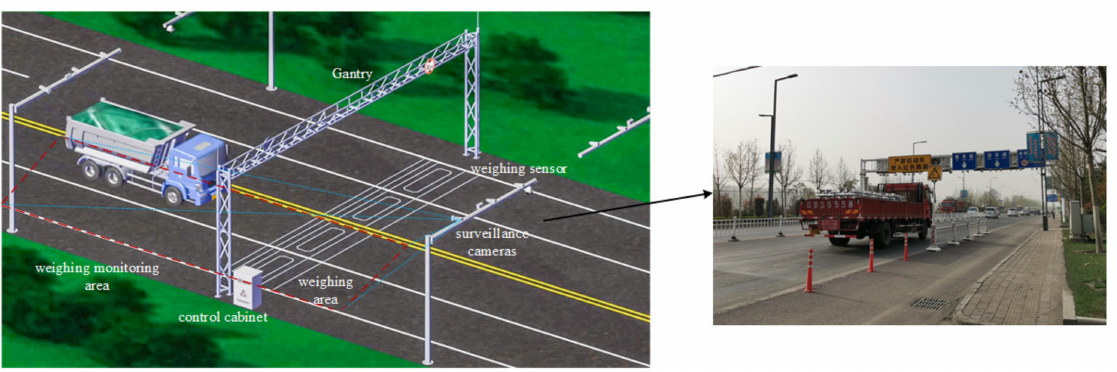
Figure 1. Hardware layout of weigh-in-motion